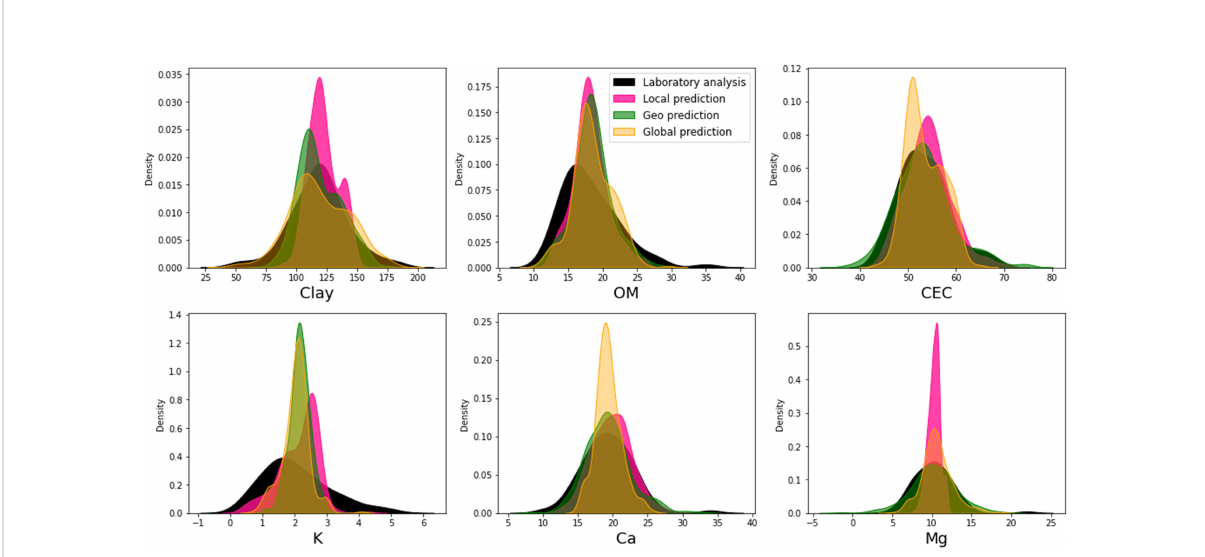
FIGURE 5 Kernel density estimate plots of clay, organic matter (OM), cation exchange capacity (CEC), potassium (K), calcium (Ca), and magnesium (Mg) for the attributes observed in the laboratory analysis of experimental area and predicted using online spectra on three strategies of calibration: only in- fi eld samples (local), adding samples from the same geological region (geological), and from different geological regions (global).